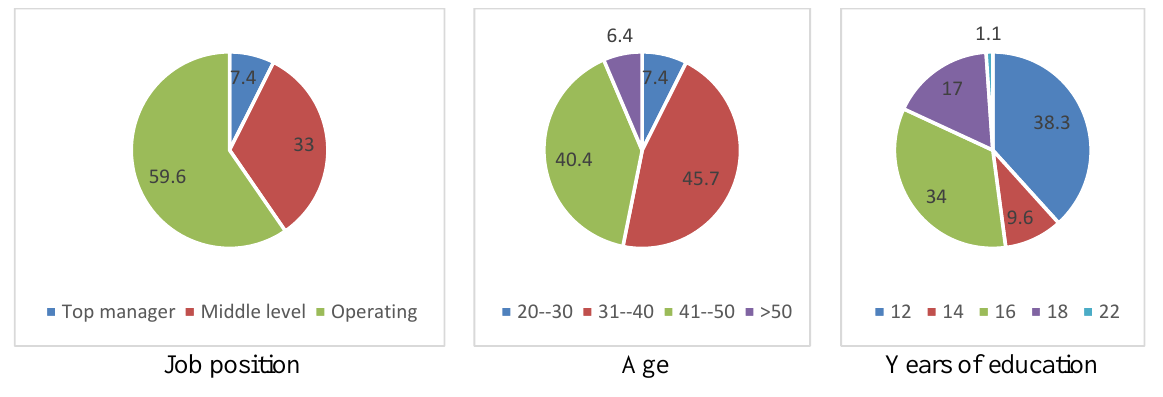
Fig. 1. Personal characteristics of the